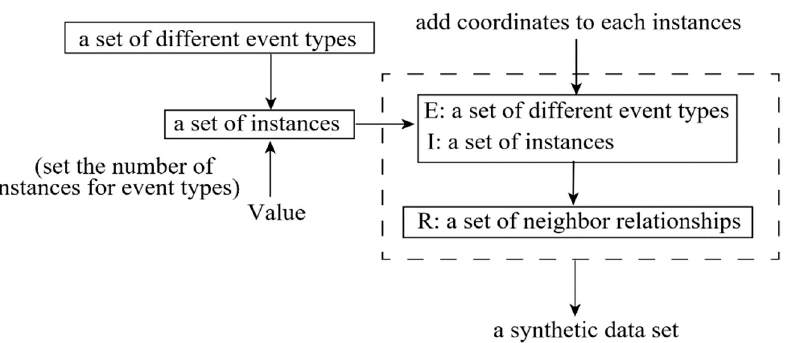
Figure 6. Generation process of a synthetic data set.